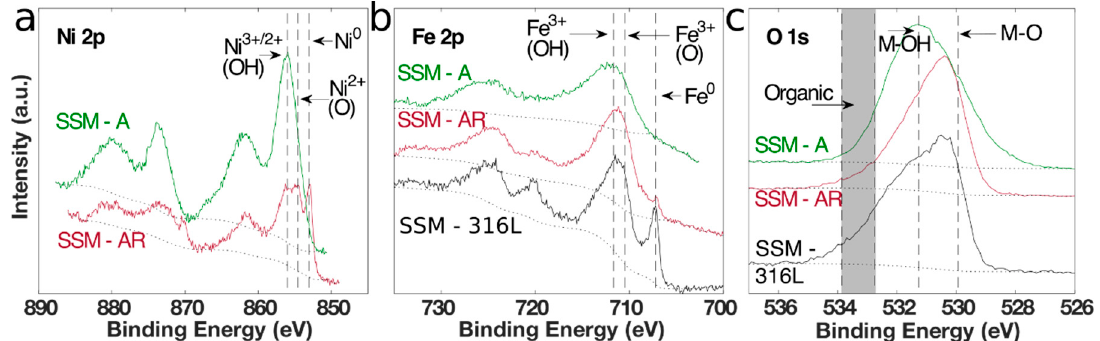
Figure 3. X-ray photoelectron spectroscopy spectra of initial SSM-316L, SSM-A and SSM-AR showing the ( a ) Ni2p, ( b ) Fe2p, and ( c ) O1s spectral lines. The labels shows the oxidation state with superscript and additionally if the metal-oxygen peaks involves oxygen (O) or hydroxide (OH). All peak positions are taken from the deconvoluted spectra.